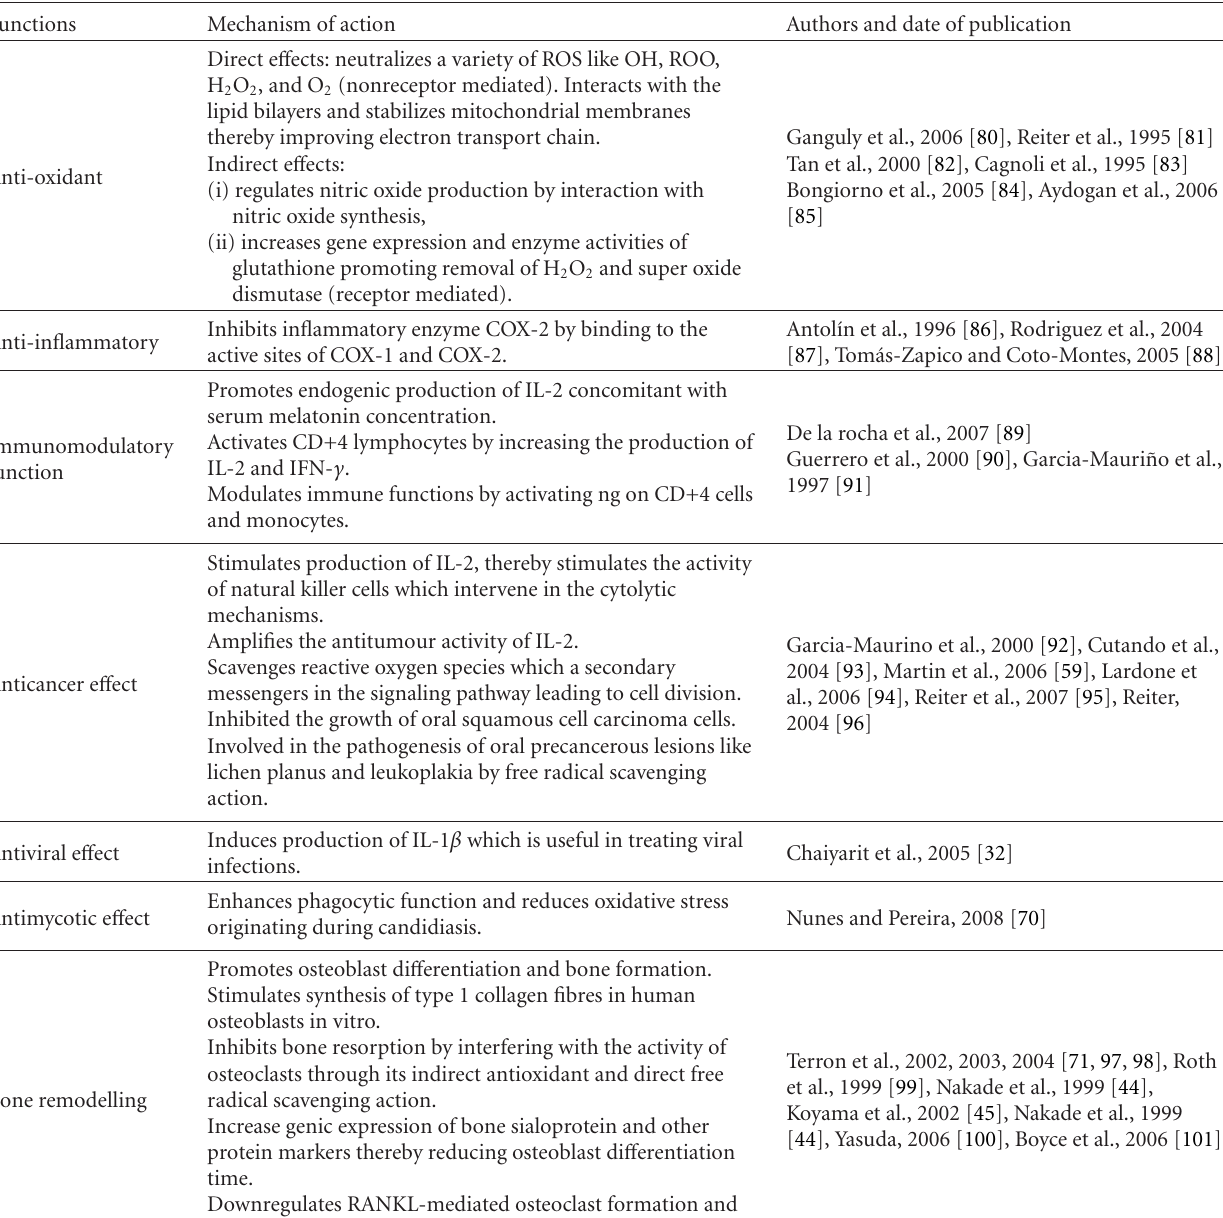
Table 1: Properties and functions of